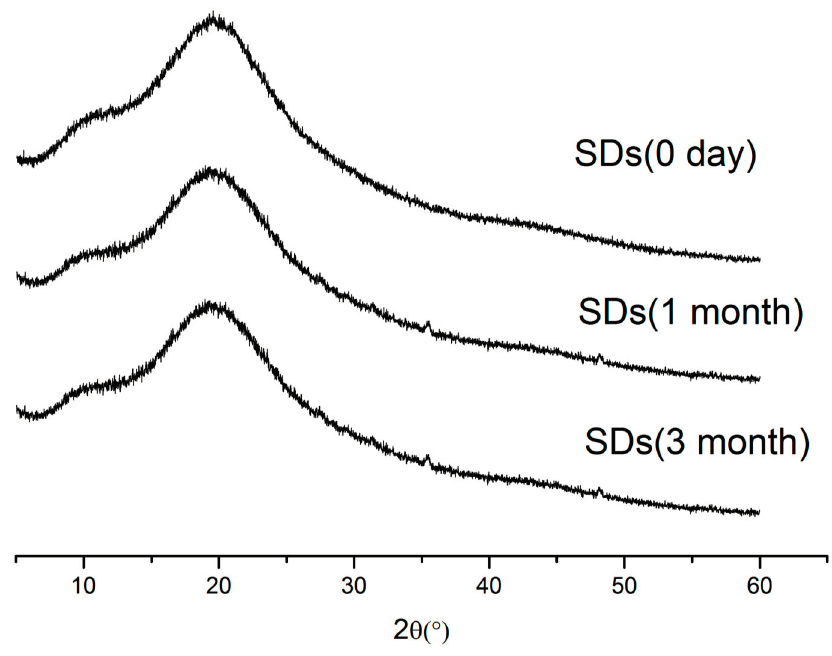
Figure 7. XRPD spectra for SDs stored 0 day, 1 month, 3